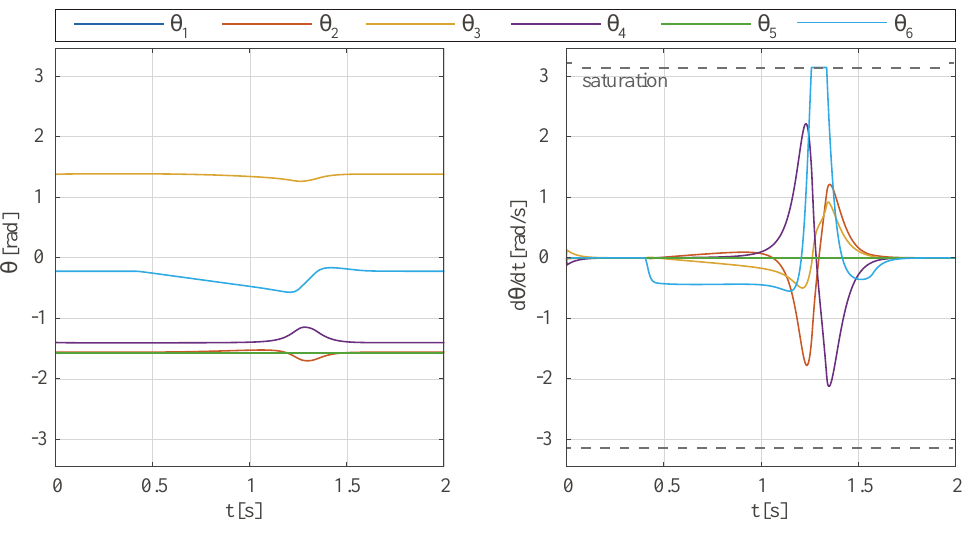
Figure 10. Joint rotations and speeds for the motion shown in Figure 7. Table 3. Comparison between different modes. Example of Figures